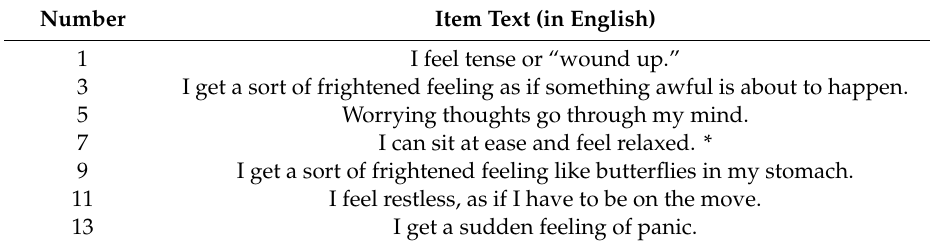
Table 1. Items of the Hospital Anxiety and Depression Scale (HADS) † subscale for anxiety